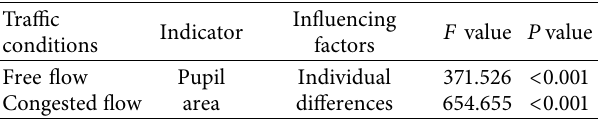
Figure 7: Comparison of drivers’ pupil area during normal driving in diferent trafc conditions. S 1– S 18 indicates the numbering of drivers. Table 9: Diference analysis in pupil area of drivers.